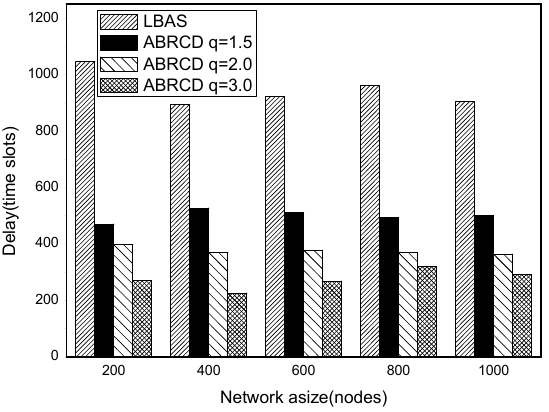
Figure 47. The impact of network size with fixed | T | = 100 on delay. Sensors 2018 , 18 , x FOR PEER REVIEW